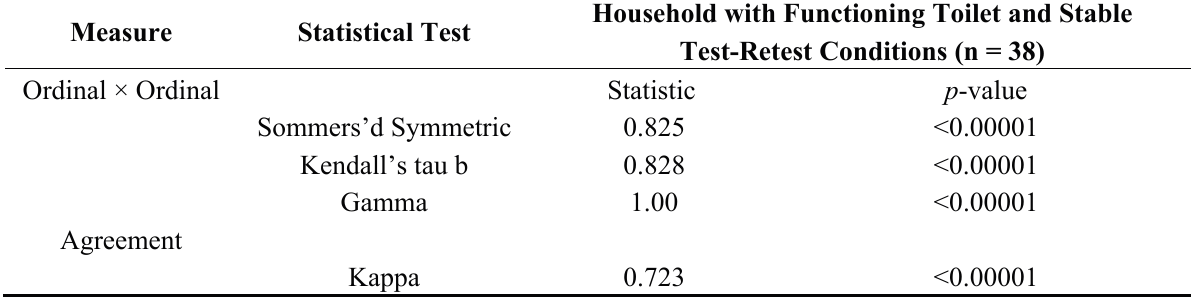
Table 4. Agreement of LUF level at F1 and F2 (Levels: rarely/never 0–32, sometimes 33–66, mostly/usually 67–99, always